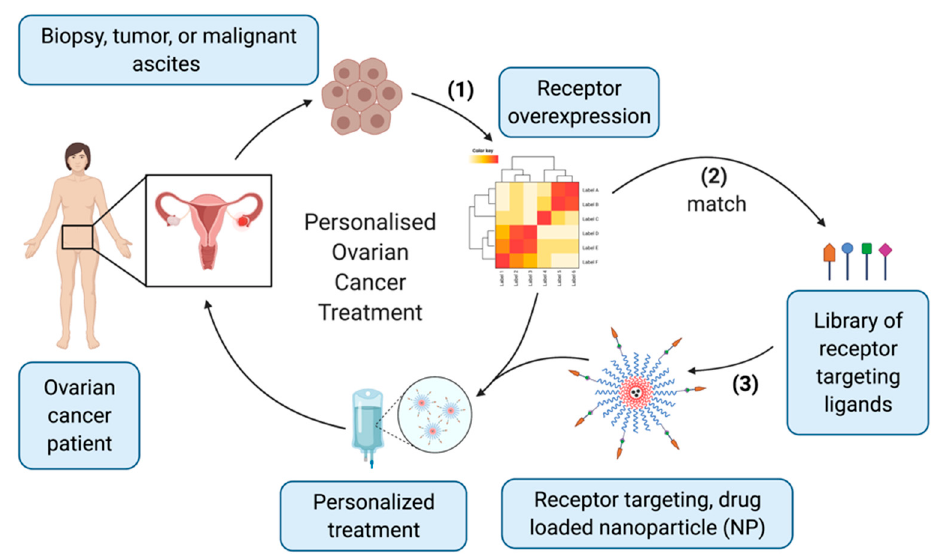
Figure 4. Schematic of personalized ovarian cancer treatment, showing ( 1 ) analysis of tumor biopsies for concurrently overexpressed GPCRs, ( 2 ) matching of receptor targeting ligands guided by receptor expression profiles, and ( 3 ) design of NPs with self-assembling polymers furnished with targeting ligands. Created with BioRender.com.